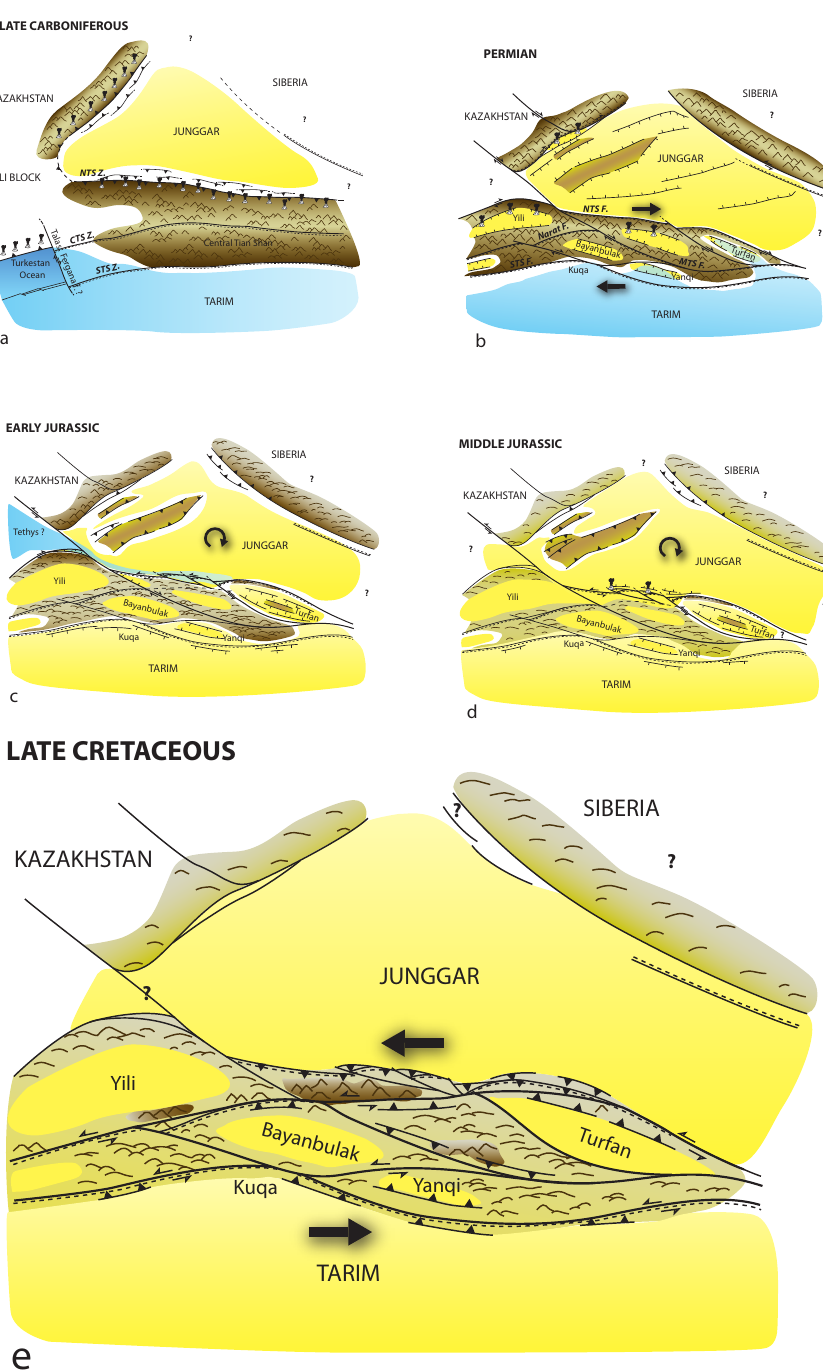
Fig. 3. Reconstitution of the main topographic pattern of the Tian Shan area through time. The brown areas correspond to mountains, the yellow areas to continental basins and the blue areas to marine basins. On Fig. 2a, NTS Z: North Tian Shan Shear Zone; CTS Z: Central Tian Shan Shear Zone; STS Z: South Tian Shan Shear Zone. See text for complete